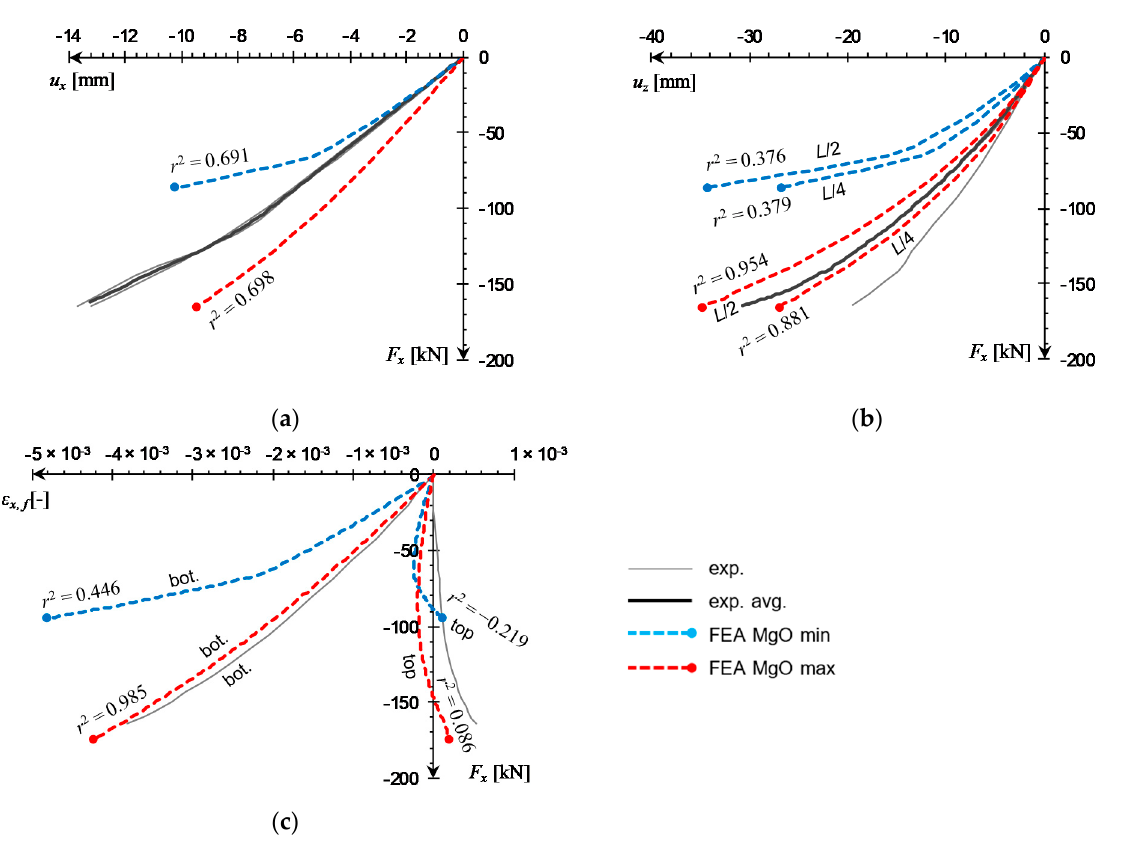
Figure 19. Comparison of natural-scale e2 panel compression test curves obtained from FEA against experimental data: